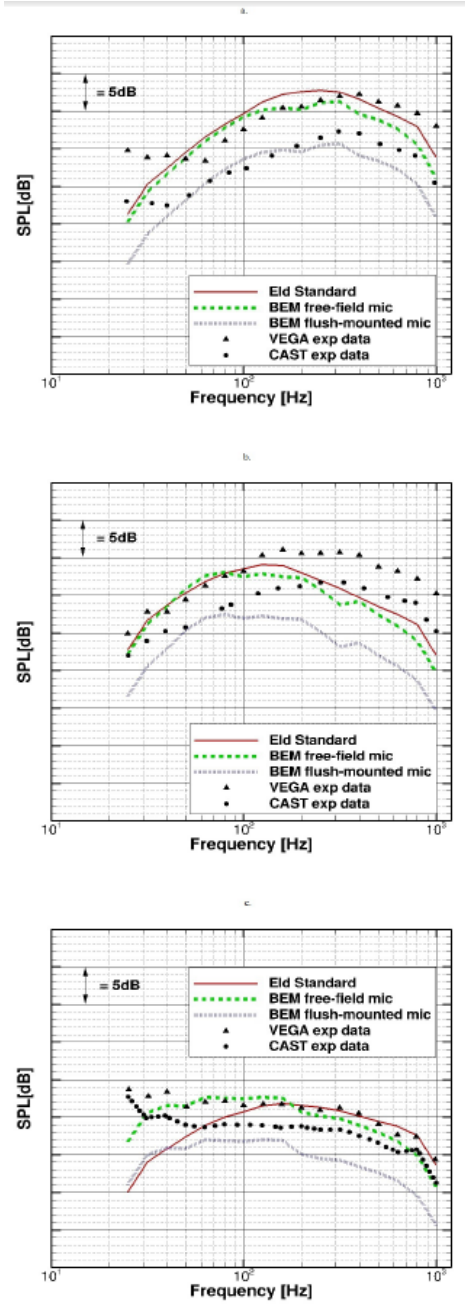
Figure 4. Sound pressure level (SPL) in third-band octave. Comparison between hybrid model results and experimental data collected at 0 ( a ), 10 ( b ) and 75 ( c ) m of altitude of the launcher interstages